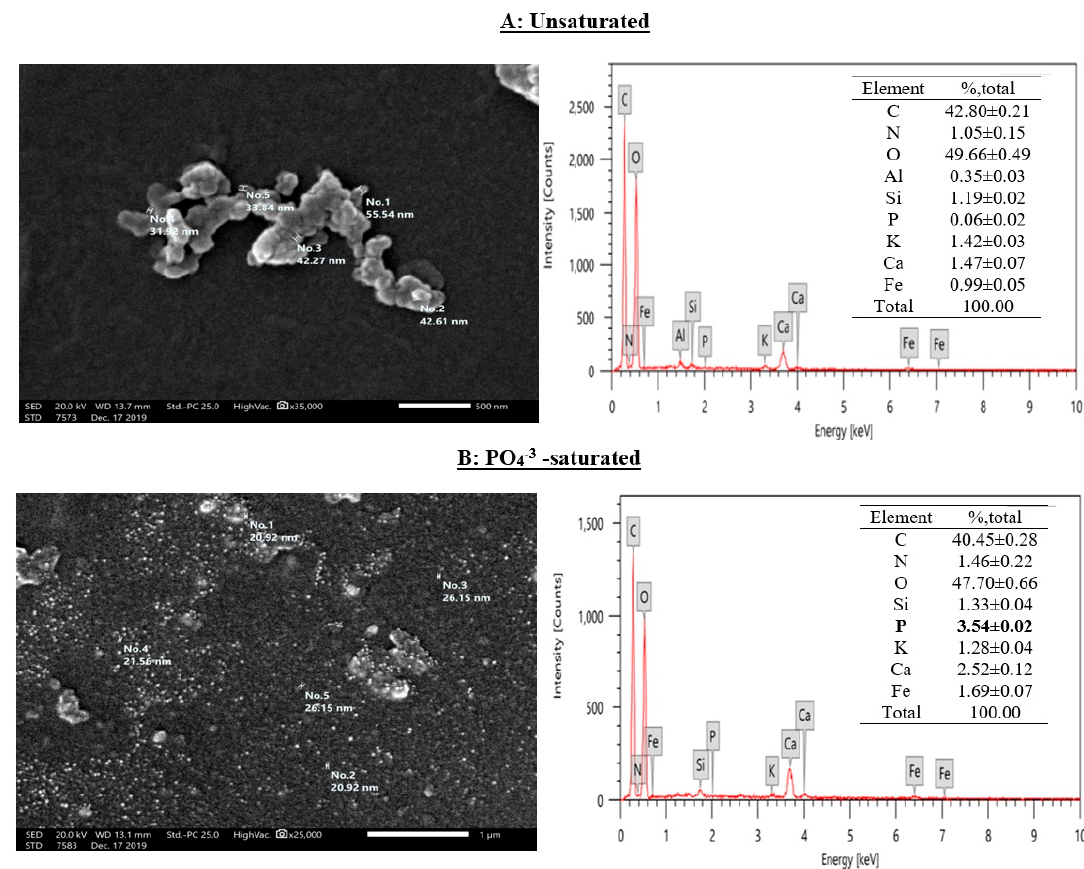
Figure 1. The scanning electron microscopy (SEM) image and energy dispersive X-ray elemental distribution (EDX) of un-saturated ( A ) and PO 4 − 3 -saturated ( B )-nSD-KF.